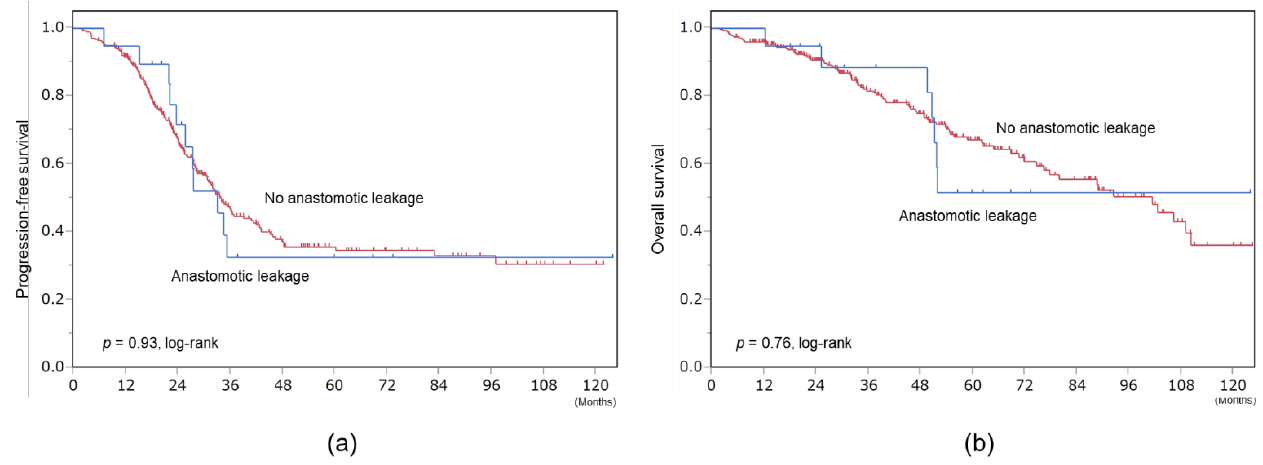
Figure 3. Survival. ( a ) Progression-free survival. ( b ) Overall